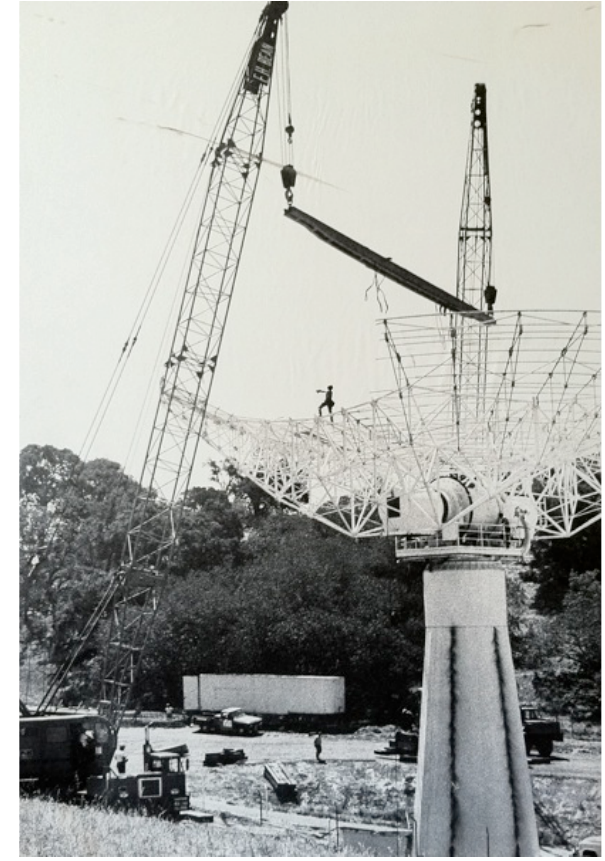
Figure 1. The 27m ISR antenna at Stanford University, California.